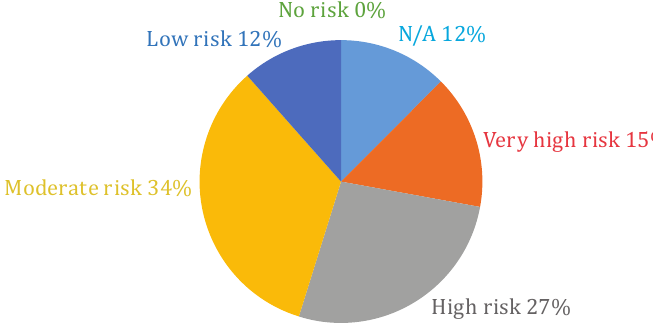
Figure 18. Rating of Drainage defects